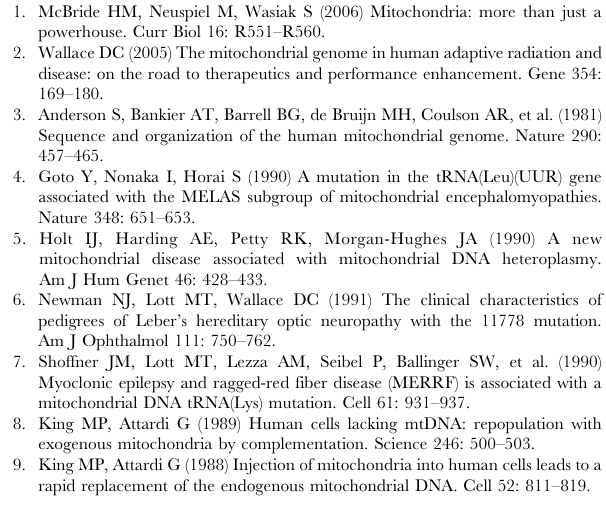
Table S1 Activity means of mitochondrial enzymes in PC-3 fusion